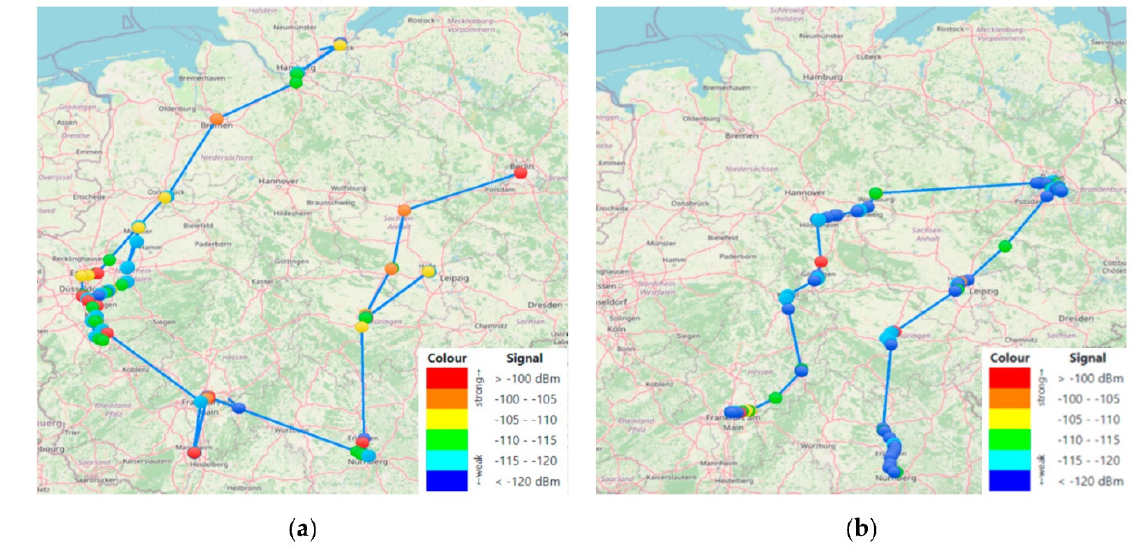
Figure 2. LoRaWAN network coverage in: ( a ) TTN/TTI; ( b ) TPN. Table 1. LoRaWAN measurement points by minimum speed (km/h) .